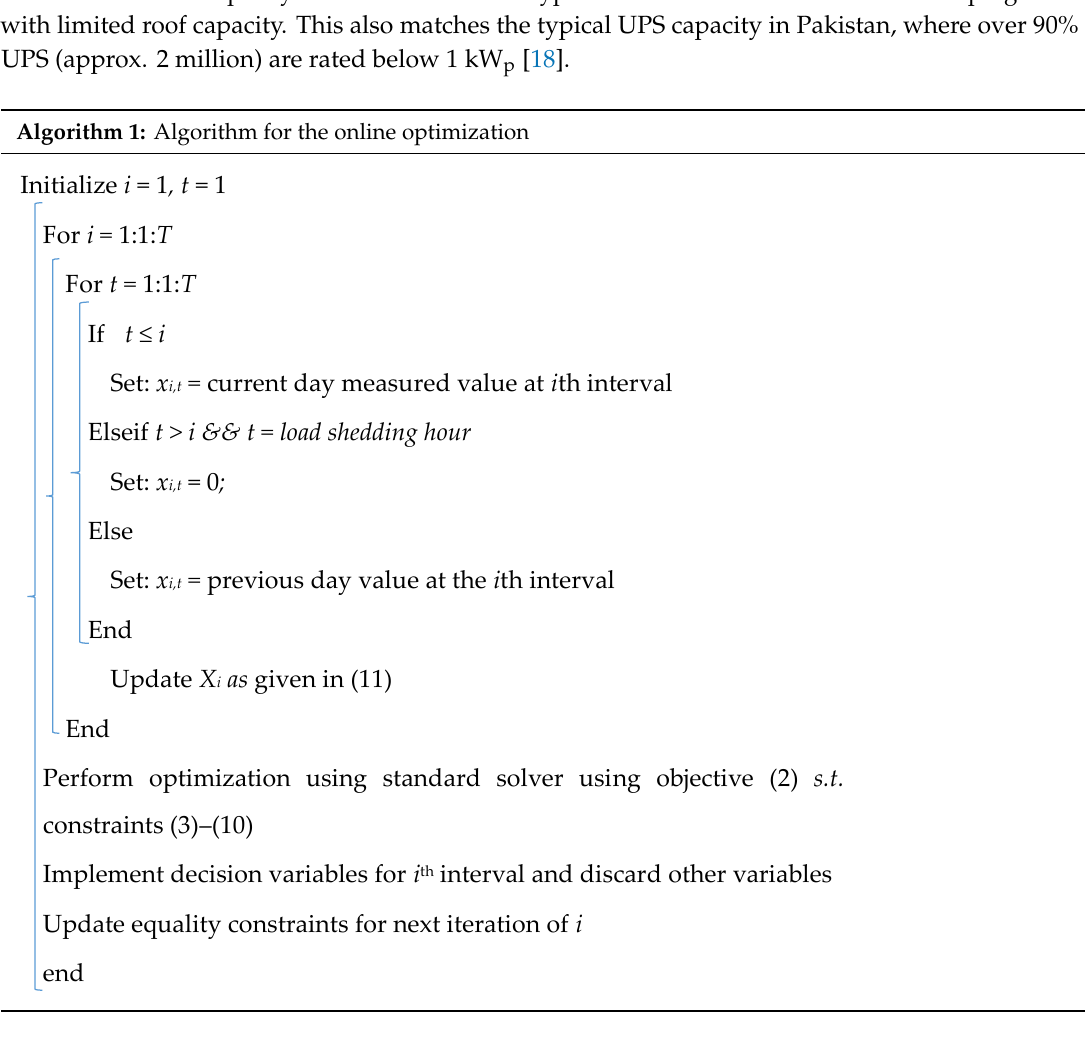
Energies 2019 , 12 , x FOR PEER REVIEW